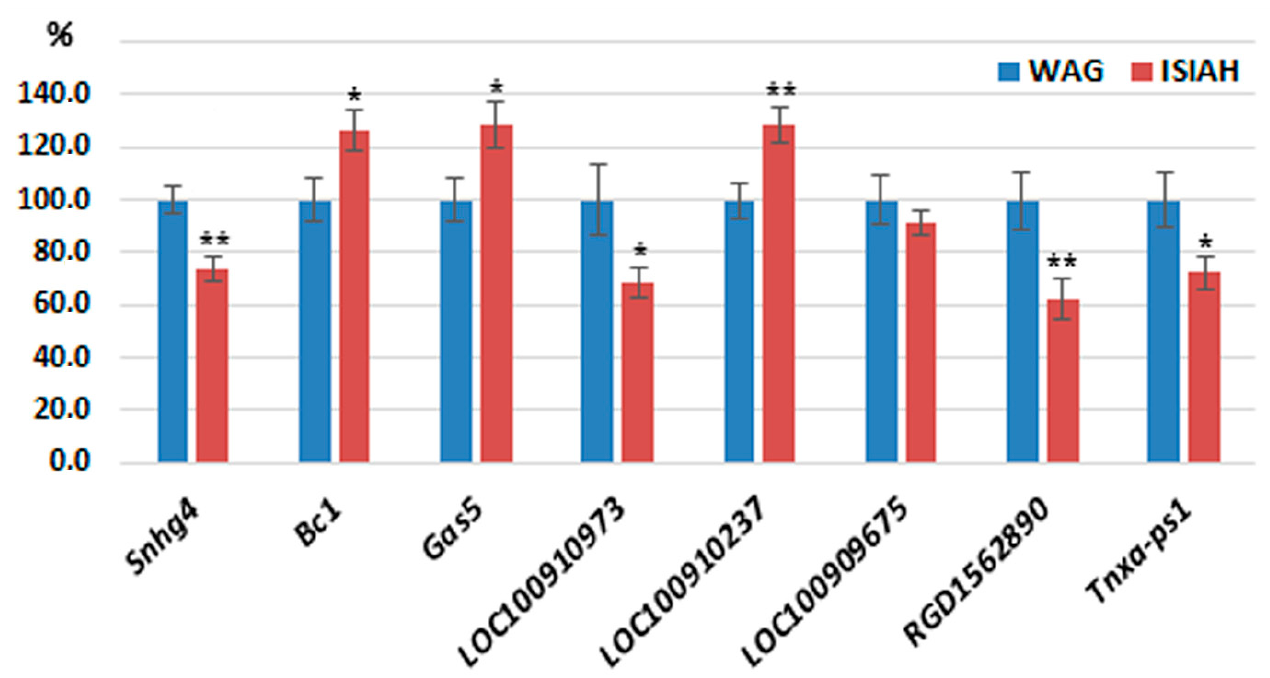
Figure 2. Relative abundance of lncRNAs measured by qPCR in the hypothalamus of ISIAH and WAG rats. The normalized RNA level in control samples of the WAG rats was set to 100%. Vertical bars denote standard error of the mean. ISIAH ( n = 10), WAG ( n = 9). As an internal control, we employed the geometric mean of the amplification data of three reference genes: Gapdh , Hprt , and Nono . * p < 0.05; ** p < 0.01 (Student’s t -test).